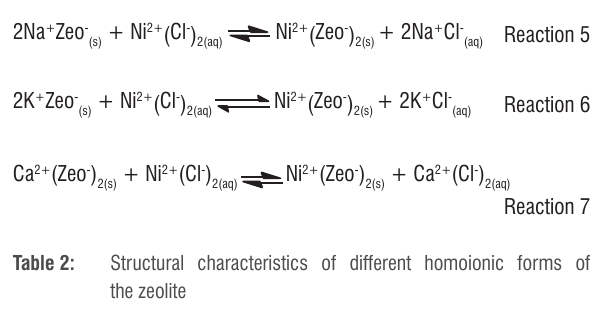
Structural characteristics of different homoionic forms